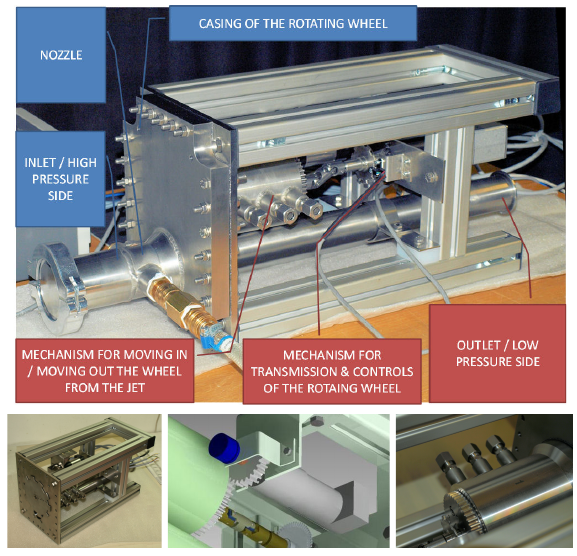
Figure 6. Combustion Bay One (CBOne)’s siren model 3G [31]: Main features ( top ) and details ( bottom ) showing the open casing, the amplitude gear, and the cooling